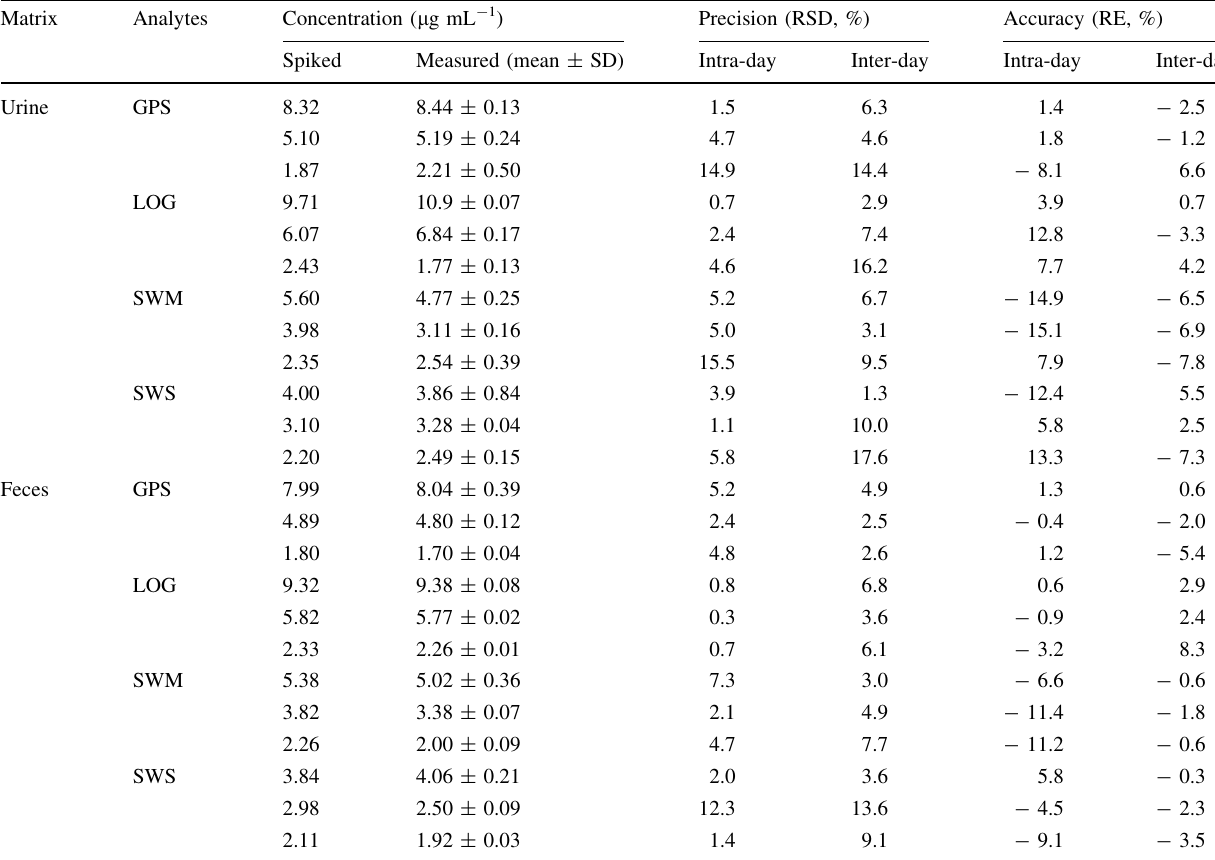
Table 4 Intra-day and inter-day accuracy and precision of four bioactive ingredients in rat urine and feces QC samples Matrix